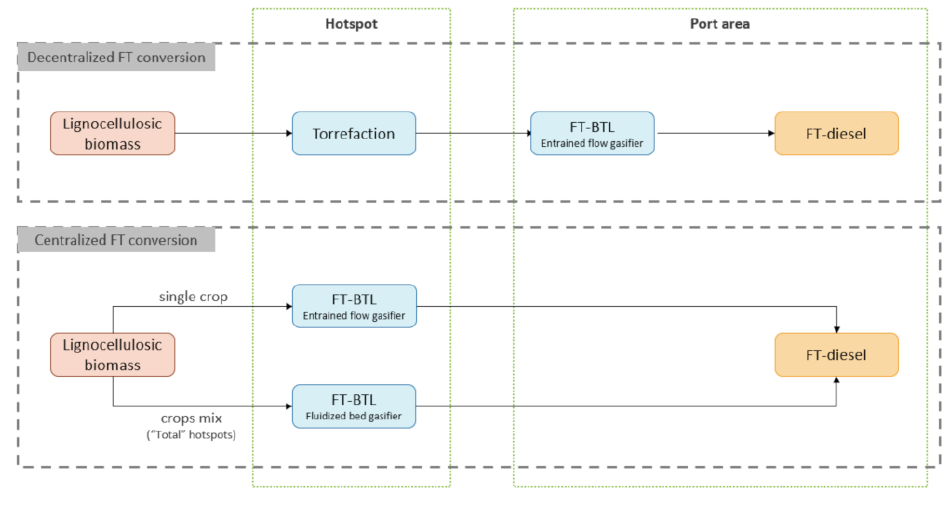
Figure 5. FT-BTL